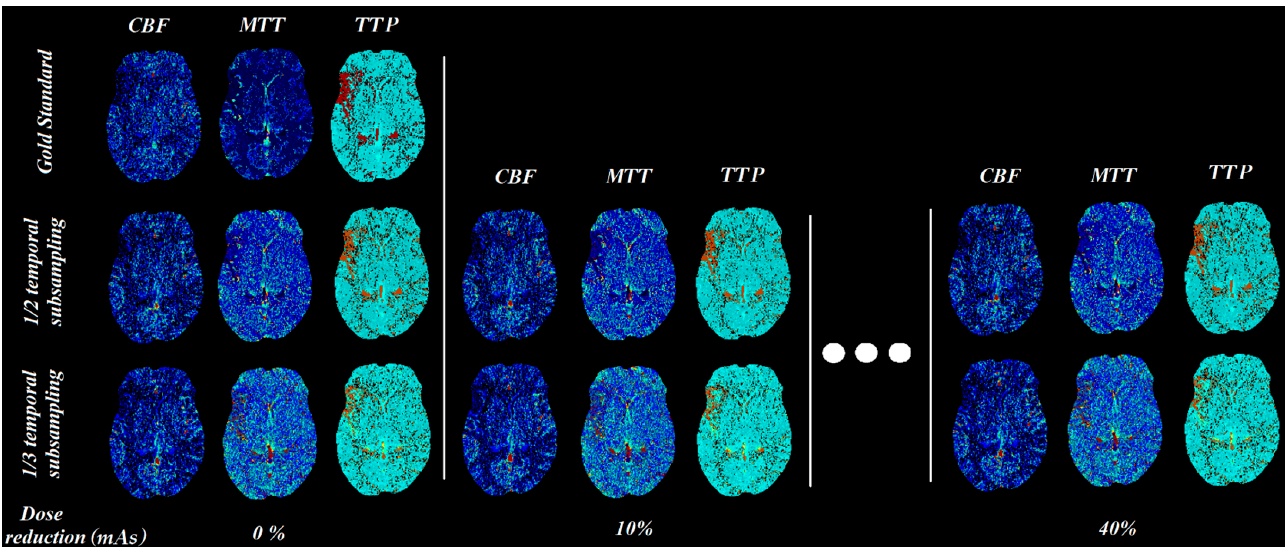
Figure 8. CBF, MTT, and TTP parametric maps for different mAs settings (simulated by adding noise and temporal sub- sampling).